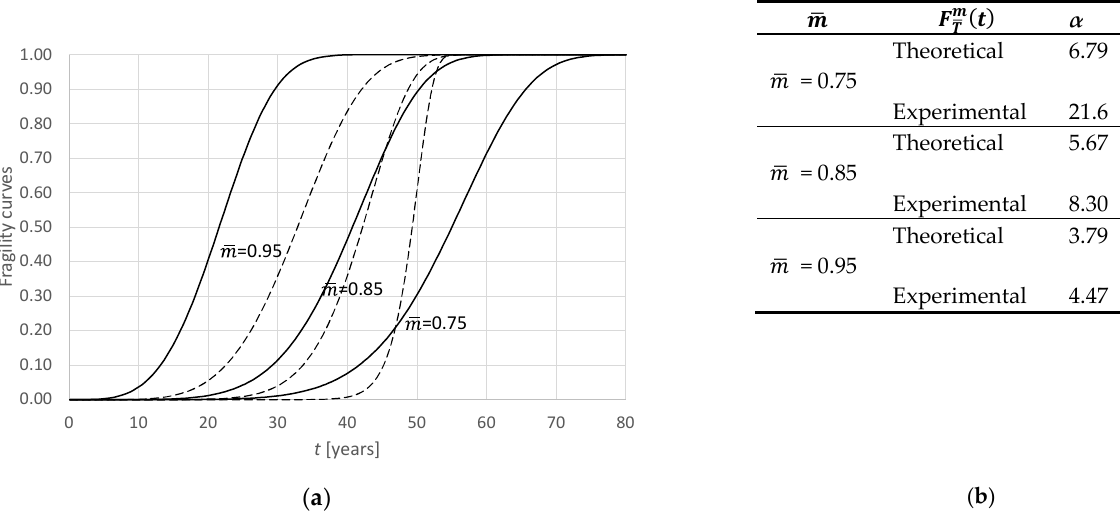
Figure 9. Scenario 3: ( a ) Comparison between experimental curves obtained for scenario 3 and the fragility curves defined as “statistical truth”. ( b ) Parameters of the theoretical and experimental distributions compared.